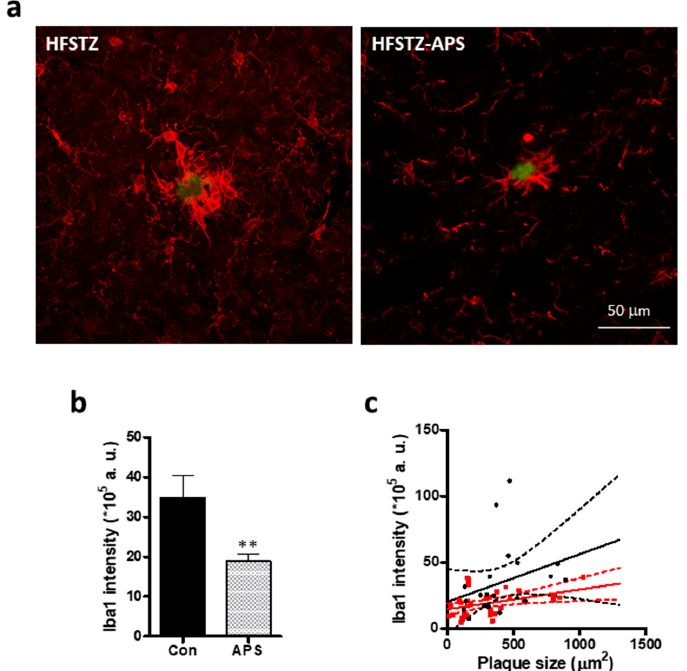
Figure 7. APS ameliorated HFSTZ-augmented activation of plaque-associated microglia. APP/PS1 mice were treated with HFSTZ ( n = 4) or HFSTZ-APS ( n = 4). ( a ) Representative images of the plaque-associated microglia immunostained with anti-Iba-1 antibody. Scale bar, 50 μ m; ( b ) Immunoreactivity of Iba-1 in plaque-associated microglia in HFSTZ and HFSTZ-APS mice. Data are shown as mean ± SEM. ** p < 0.001, significant difference from HFSTZ group; ( c ) The correlation of plaque size and Iba1 intensity was analyzed by a scatter plot of plaque-associated microglia and plaque size from the selected plaques with vehicle (black) and APS (red) treatments. Solid lines is linear regression lines and dashed lines are 95% confidence intervals, R 2 = 0.33 for HFSTZ group and R 2 = 0.61 for HFSTZ-APS group.